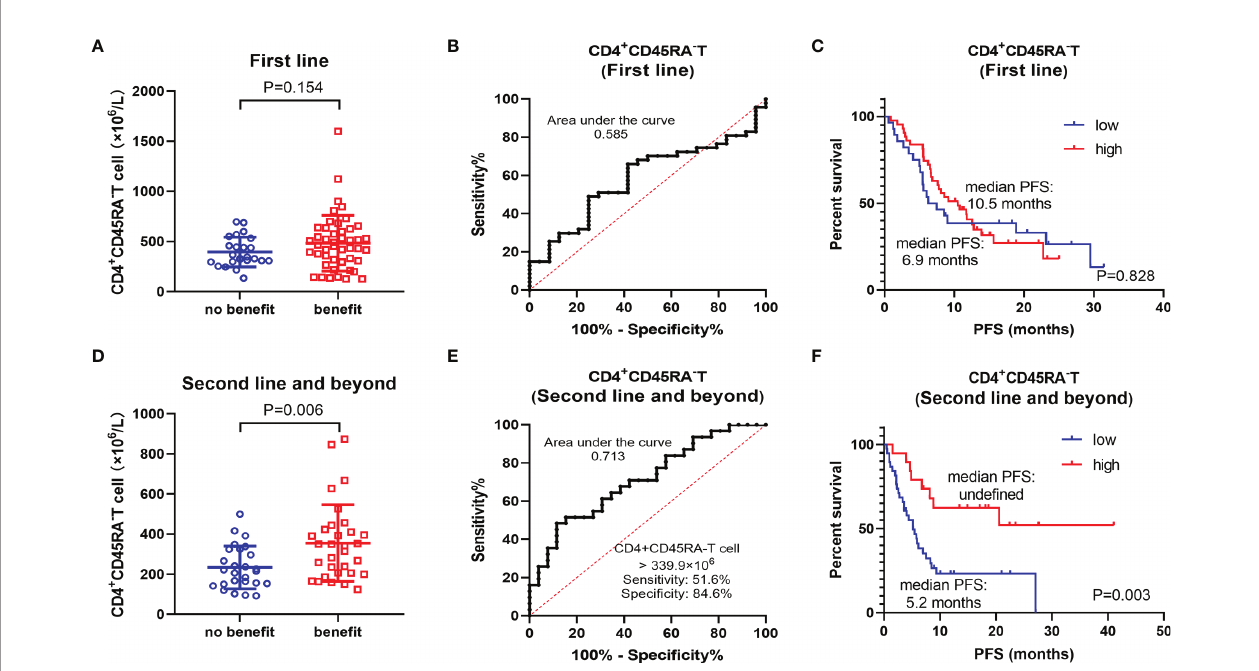
FIGURE 3 | Subgroup analysis of different treatment lines. (A) Differences of CD4 + CD45RA − T cell between bene fi t group and non-bene fi t group in the fi rst-line patients. (B) ROC curve of CD4 + CD45RA − T cell in the fi rst-line patients. (C) Kaplan – Meier survival curve of different levels of CD4 + CD45RA − T cell in the fi rst-line patients. (D) Differences of CD4 + CD45RA − T cell between the bene fi t group and the non-bene fi t group in the second-line and beyond patients. (E) ROC curve of CD4 + CD45RA − T cell in the second-line and beyond patients. (F) Kaplan – Meier survival curve of different levels of CD4 + CD45RA − T cell in the second-line and beyond